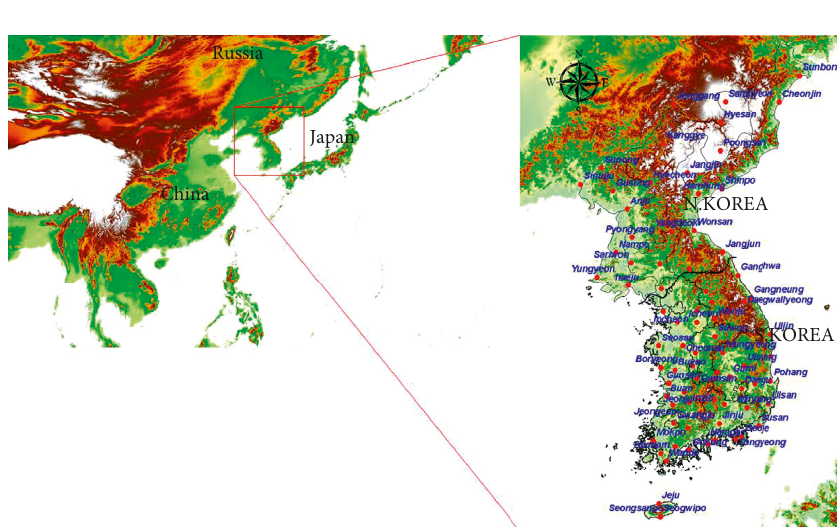
Figure 2: Weather stations used for the